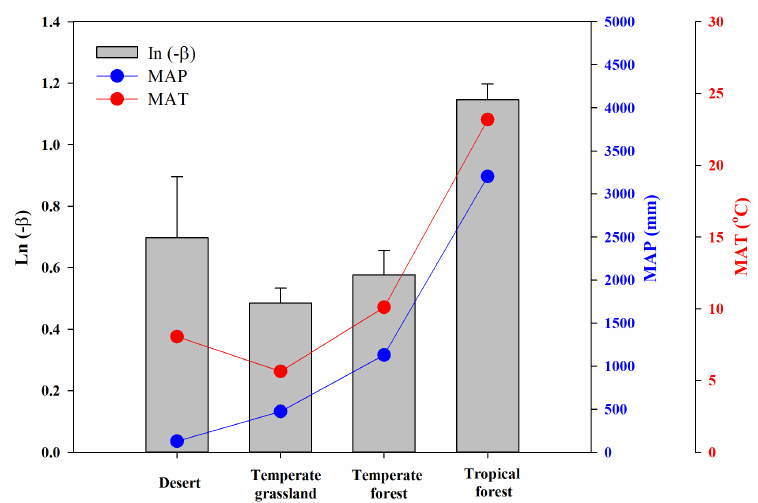
Figure 3. Variations of mean β with biome types. Blue and red points present mean annual precipitation (MAP) and mean annual temperature (MAT) for each biome,